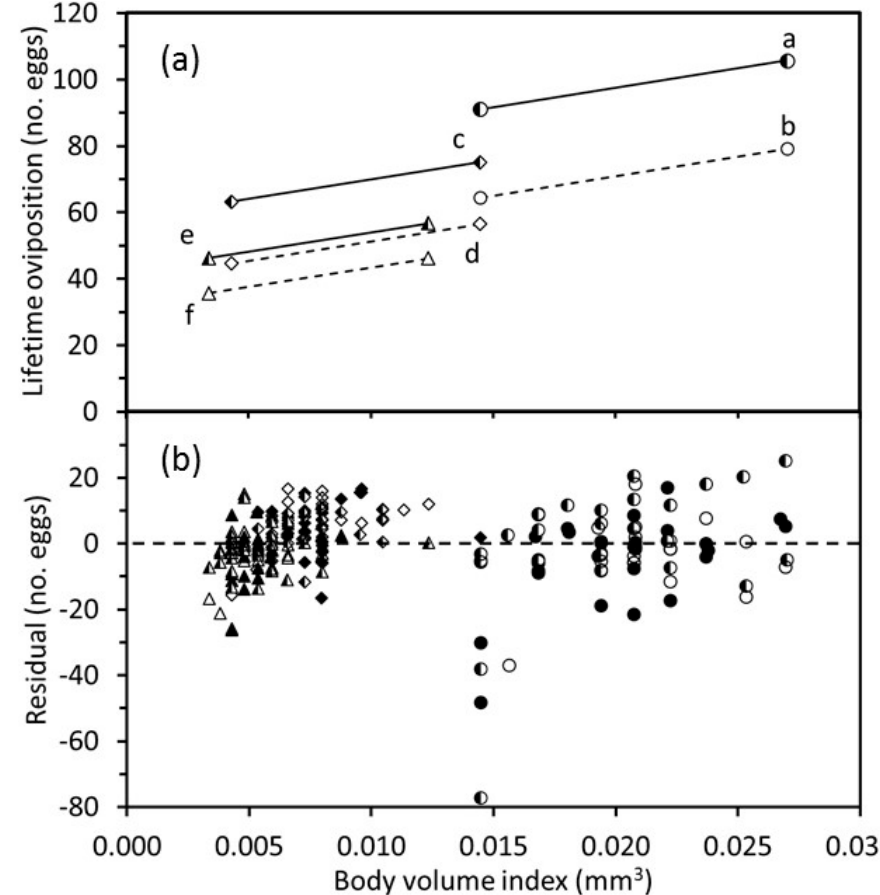
Figure 5. Relationship between the body-volume index and lifetime oviposition of Eretmocerus warrae as influenced by temperature during the immature development and adult stages. ( a ) Fitted regression lines projected over the ranges of observed body-volume indices. Treatments shown by each line (immature temperature:adult temperature in °C) are: a, 20:20 and 20:26; b, 20:32; c, 26:20 and 26:26; d, 26:32; e, 32:20 and 32:26; and f, 32:32. ( b ) Residuals from the regression analysis. Symbols indicate immature temperatures: 20— , 26— , 32— ; and adult temperatures: 20—filled symbols, 26—half-filled symbols, 32—open symbols ( p < 0.001). Lines a, c, and e represent two adult temperatures as differences were not statistically significant.